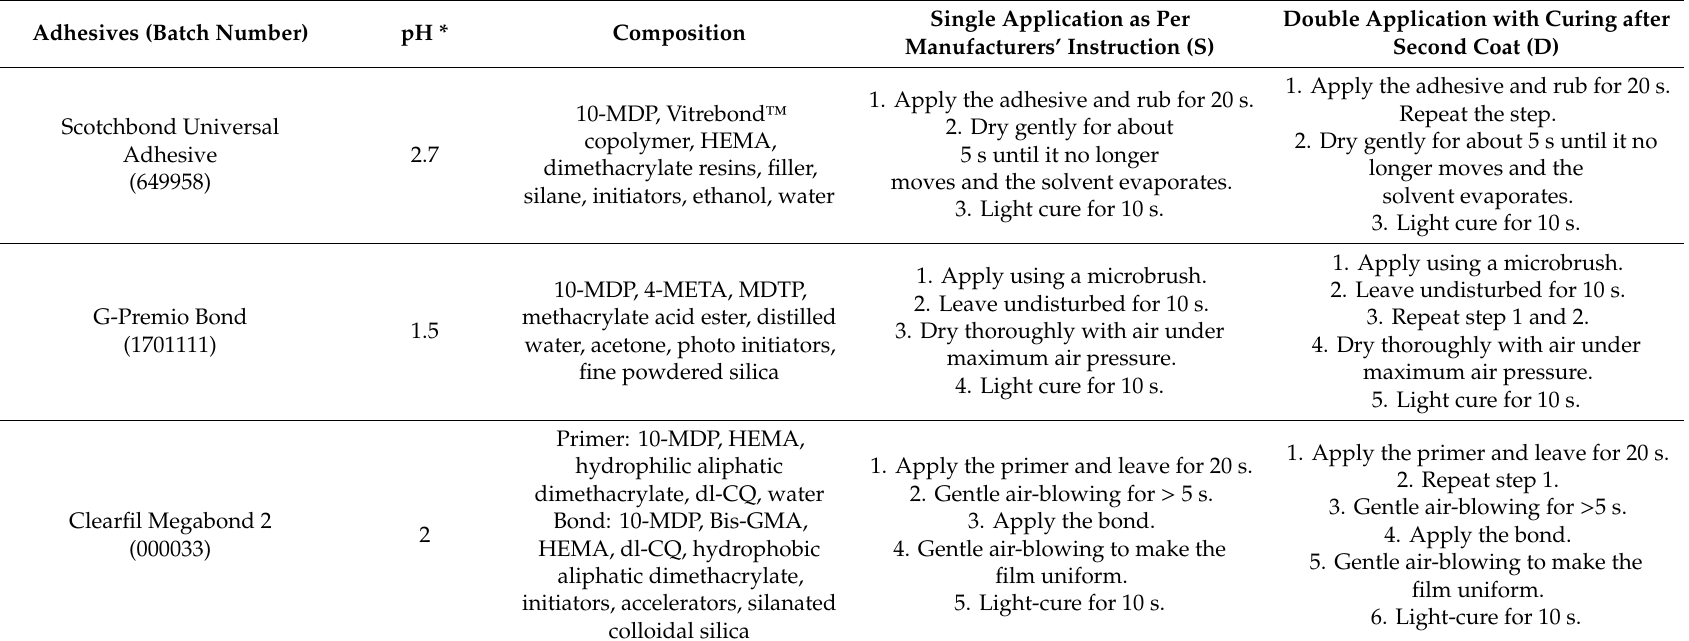
Table 2. Adhesive system (batch number), composition, and application